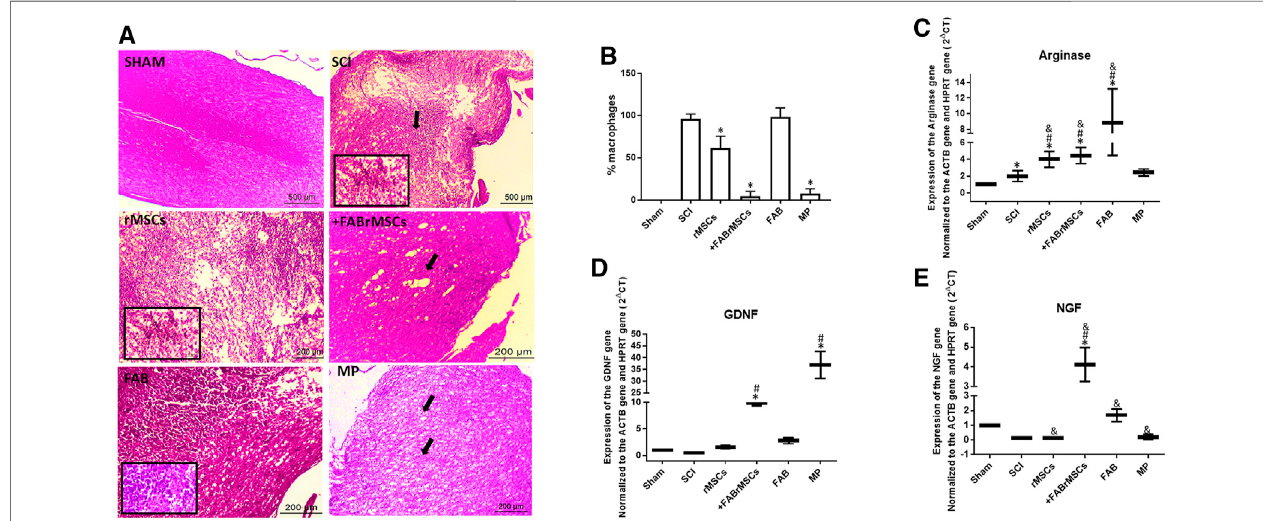
FIGURE5| Generalhistopathologyofthespinalcordofanimals8 daysafterbeingsubjectedtospinalcordinjury(SCI)anddifferenttreatments. (A) Representative longitudinalsectionofanormalspinalcord(sham animals), andfromanimals treatedwithasingleapplication of1×10 6 controlrMSCs or1×10 6 rMSCspretreated with agathis fl avone (+FABrMSCs), treated with one single dose of methylprednisolone (60 mg/kg i.p., MP), or treated daily with agathis fl avone (10 mg/kg i.p., FAB); hematoxylin and eosin (H&E), x40; details x100. Abundant foamy macrophages and extensive area of liquefactive necrosis with strong macrophage reaction are observed in the spinal cord of animals with SCI (spotlight), also observed in the spinal cord of animals that received implant of control rMSC (spotlight), and in less expansion of animals treated daily with FAB. However, in the spinal cord of animals that received implant of +FABrMSCs, isolated vacuolization by demyelization and waleriandegeneration(arrow)areobserved.InthespinalcordofanimalstreatedwithMP,diffuseandmildvacuolizationbydemyelinationofwhitematterisobserved. (B) Quanti fi cation of foamy macrophages in injured spinal cord tissue. The results are expressed as the media of percentage in three independent experiments and were analyzed by Kruskal – Wallis ANOVA followed by Dunn ’ s post-test (*) p ≤ 0.05 compared to SCI group. (C – E) : Expression of neurotrophic factors and arginase in the spinalcordofanimals8 daysafterbeingsubjectedtospinalcordinjury(SCI)anddifferenttreatments.ExpressionofmRNAforneurotrophicfactorsNGFandGFDN,and forenzymearginase,wasanalyzedwithRT-qPCR;Sham=Non-lesioned;SCIandothergroups=Lesioned;valuesexpressedasmean±standarddeviation;signi fi cant differences areexpressed as* p ≤ 0.05 when compared to thecontrol NL; # p ≤ 0.05 when compared toFAB 0.1 μ M NL treatment; and p ≤ 0.05 when compared to the